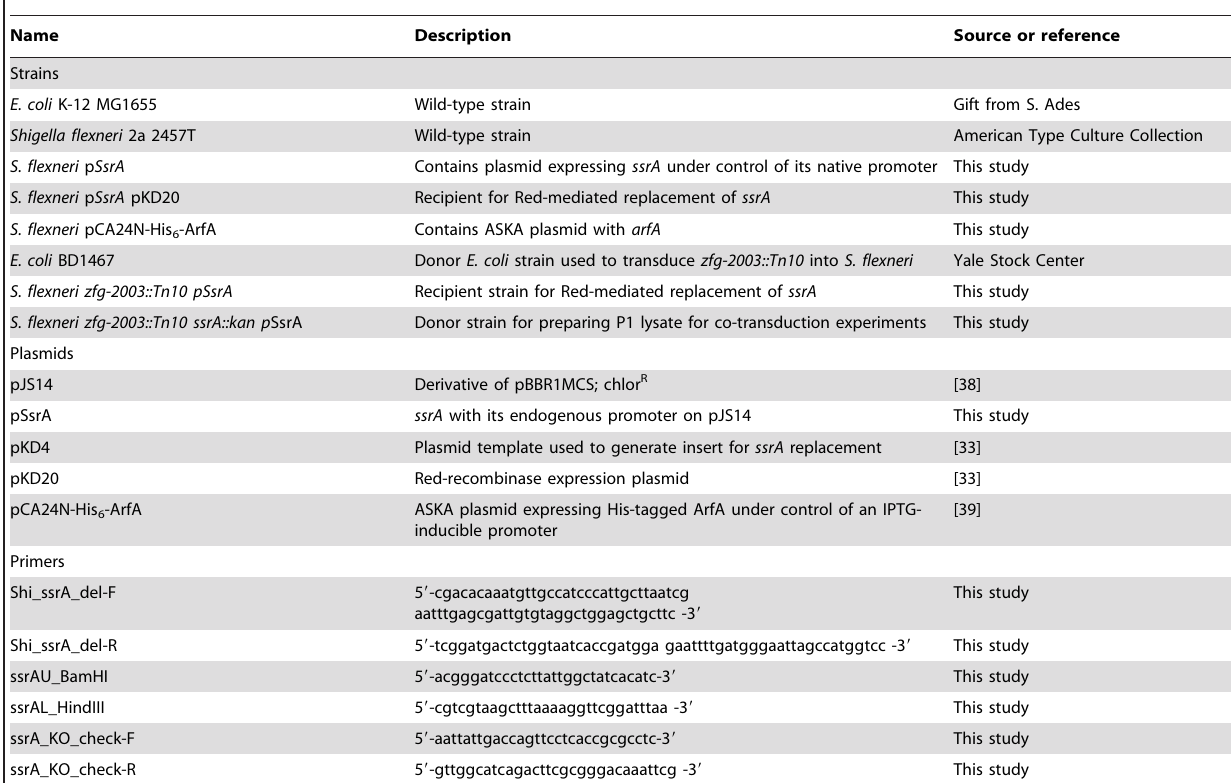
Table 1. Strains, plasmids and primers used in this